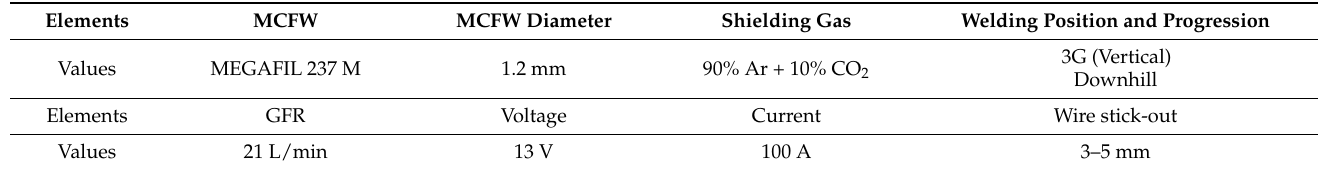
Table 2. Particulars of experimental settings during welding.